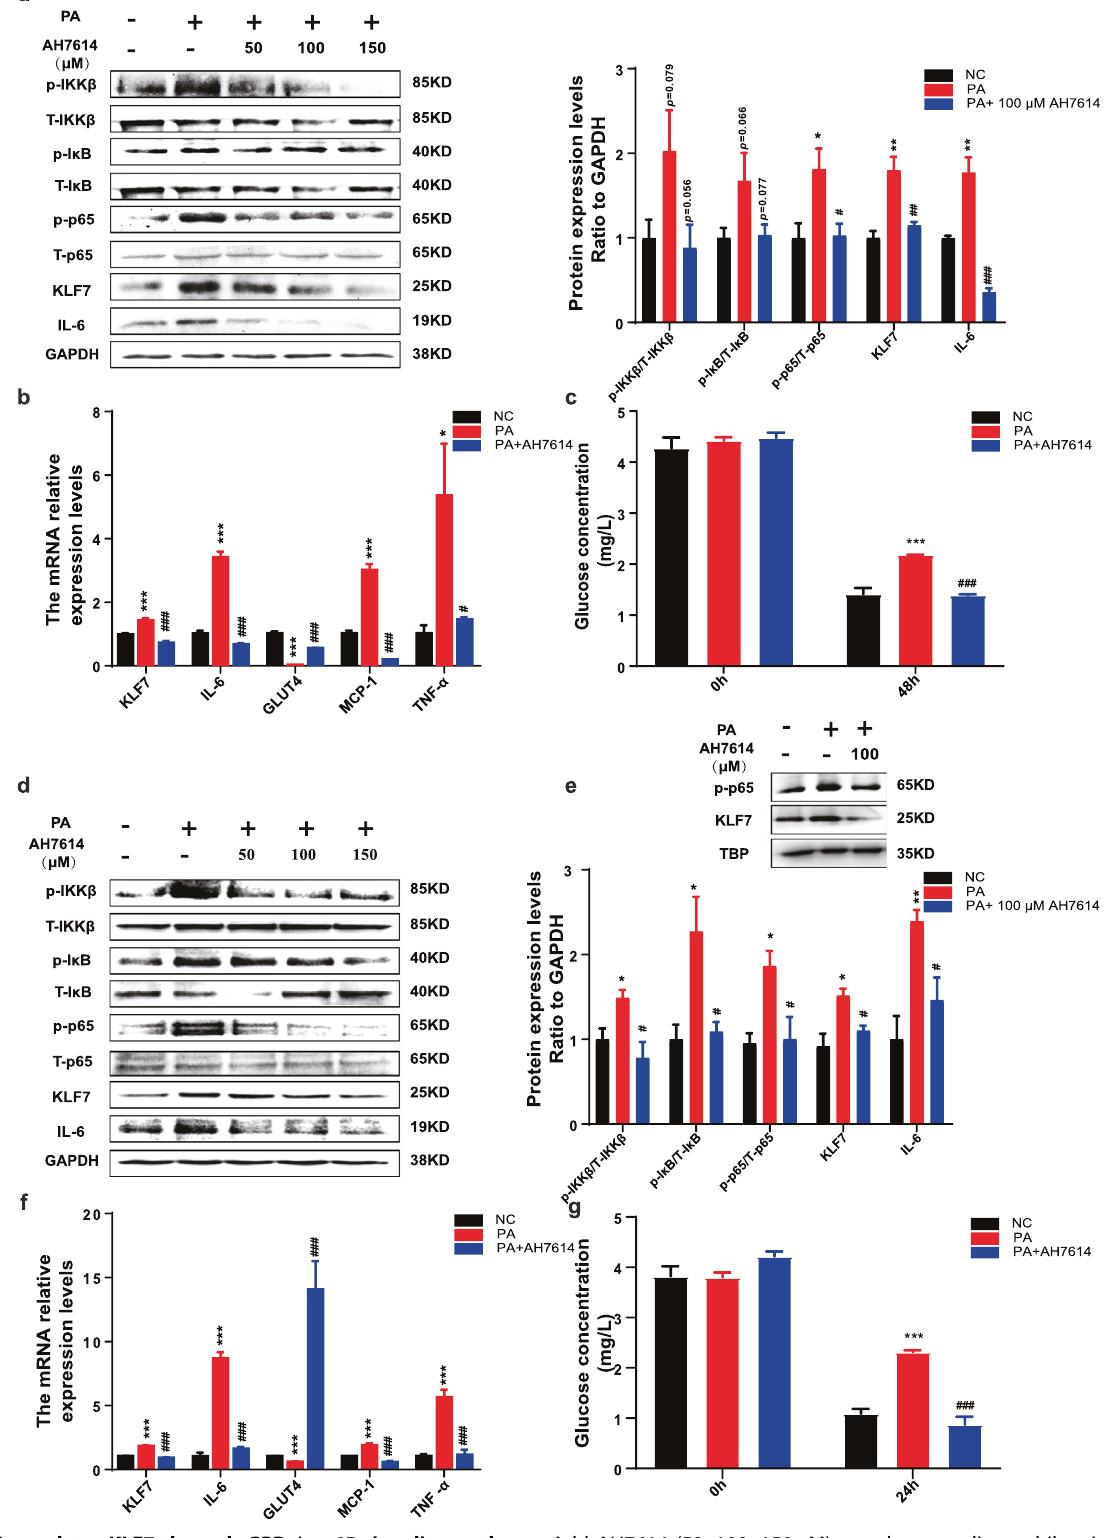
Fig. 2 PA regulates KLF7 through GPRs/p-p65 signaling pathway. Add AH7614 (50, 100, 150 μ M) to culture medium while stimulated by 200 μ M PA, the protein expression levels of p-IKK β /T-IKK β , p-I κ B/T-I κ B, p-p65/T-p65, KLF7 and IL-6 in 3T3-L1 adipocytes ( a ) and HepG2 cells ( d ). The mRNA expression levels of KLF7, IL-6, GLUT4, MCP-1 and TNF- α in 3T3-L1 adipocytes ( b ) and HepG2 cells ( f ). The expression levels of KLF7, p-p65 in HepG2 nuclear extracts ( e ). The glucose consumption ability in 3T3-L1 adipocytes ( c ) and HepG2 cells ( g ). One-way ANOVA-LSD, *NC compared with PA group, # PA compared with AH7614 group. * p < 0.05, ** p < 0.01, *** p < 0.001, # p < 0.05 , ## p < 0.01, ### p < 0.001, the difference was statistically signi fi cant, data presented as means ±